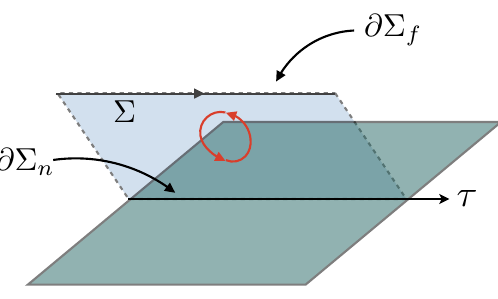
Figure 1 . Geometry of the effective action: boundary ∂ Σ n of the complex worldsheet (translucent plane) is fixed to the particle worldline in real space (solid